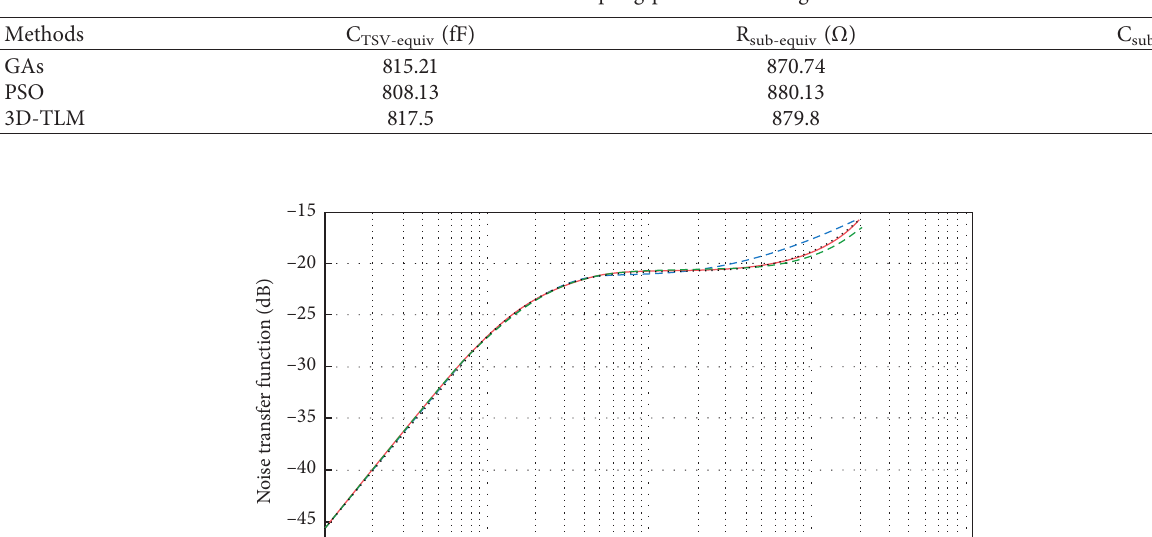
Figure 14: The proposed method and measured TSV-TSV coupling noise in the time domain (the input clock frequency at port 1 is 1GHz). Table 3: The TSV-contact noise coupling parameters using GA and 3D-TLM.